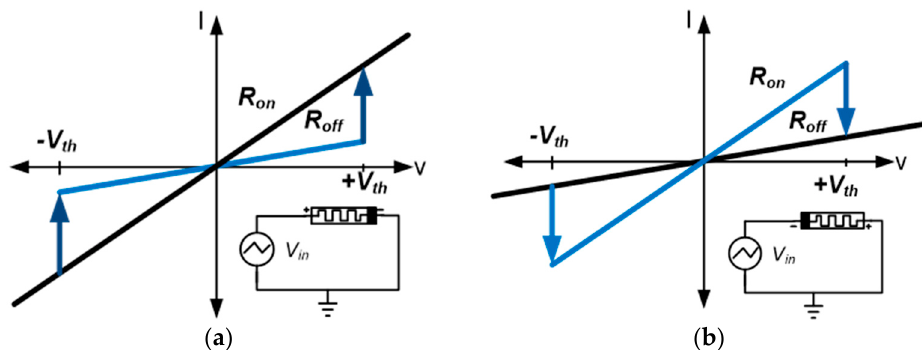
Figure 2. The ideal curve of current–voltage characteristics when ( a ) the positive terminal is connected to the supply and the negative terminal is connected to the ground and ( b ) the negative terminal is connected to the supply and the positive terminal is connected to the ground.